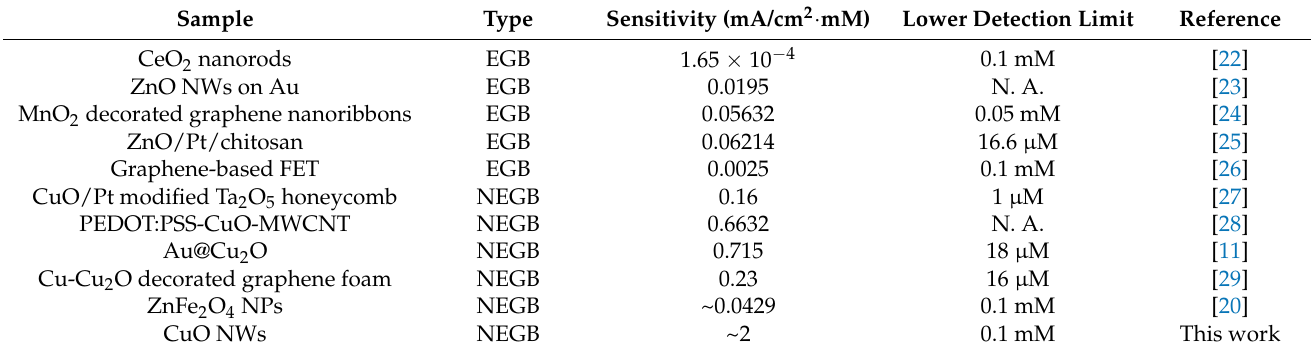
Table 1. Comparison of performance for various types of glucose